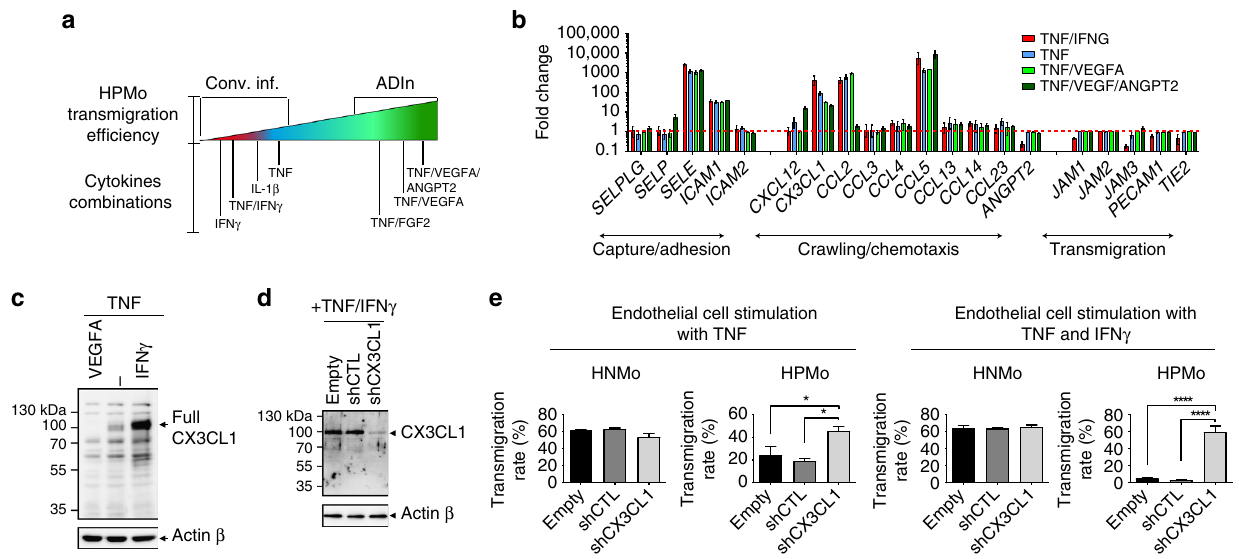
Fig. 6 High-CX3CL1 expression regulates the luminal retention of proangiogenic monocytes. a Scheme of proangiogenic monocyte transmigration map indicating how cytokines and combinations of factors affect proangiogenic monocyte transmigration. b Screening by qPCR for differential mRNA expression by endothelial cells of molecules involved in leucocyte recruitment including capture, crawling and transmigration, after indicated stimulations. Normalisation was performed with housekeeping gene mRNA levels namely ACTB and GAPDH . The level in in fl ammation is expressed as the fold-change of expression level compared to non-stimulated endothelial cells. The horizontal dashed line (red) indicates baseline level. n = 3 technical replicates, representative of three independents experiments, the data are mean ± s.e.m. c Protein expression of CX3CL1 by endothelial cells upon activation with different cytokines and combination of factors. d Western blot showing ef fi cient downregulation of CX3CL1 expression in HUVEC after transfection with a plasmid expressing CX3CL1 -targeting shRNA. e Effect of CX3CL1 downregulation on transmigration of monocyte subsets through TNF or TNF + IFN γ - activated endothelium. n = 4 independent experiments with monocytes from four different donors, the data are presented as mean ± s.e.m., * p < 0.05; **** p < 0.0001 in ANOVA